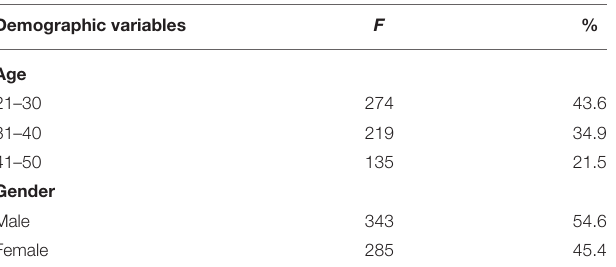
TABLE 1 | Demographic details of the sample ( N = 628).